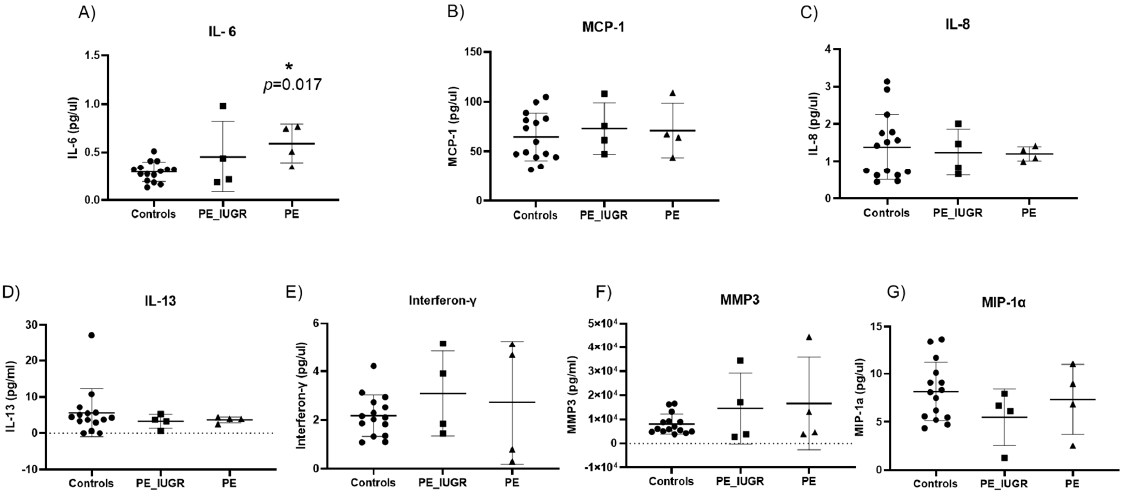
Figure 6. Senescence-associated secretory phenotypes (SASP) in pre-eclampsia with or without intrauterine growth restriction. ( A ) IL-6 was significantly increased in maternal plasma of pre-eclampsia only pregnancies ( p = 0.017) when compared with controls. All other cytokines: ( B ) MCP-1, ( C ) IL-8, ( D ) IL-13, ( E ) Interferon- γ , ( F ) MMP-3, and ( G ) MIP-1 α showed no significant differences between pre-eclampsia subgroups compared with controls. Data are represented as mean ± SD, p < 0.05; p -value < 0.05, it is flagged with one star (*).